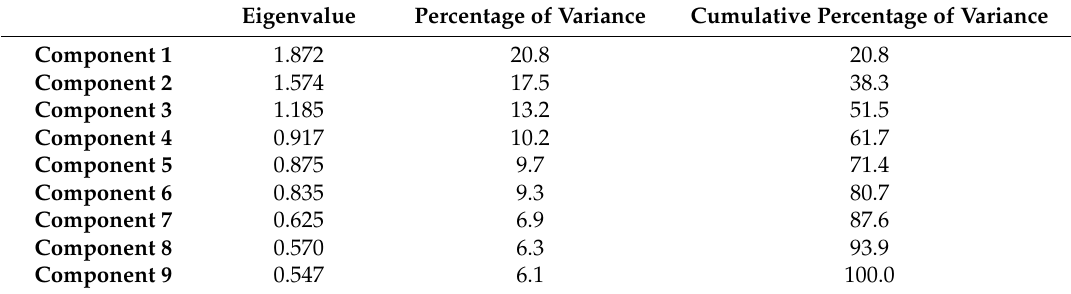
Table 3. Variance explained by each component of the principal components analysis (PCA) of household-based assets.